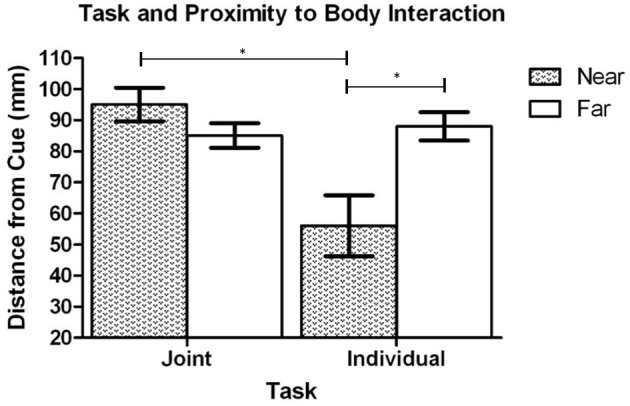
Experiment 1: Mean distance of the dowel to the cued location in Near and Far space during the Individual and Joint tasks. Error bars represent the standard error of the mean. The * indicates a statistically significant difference.